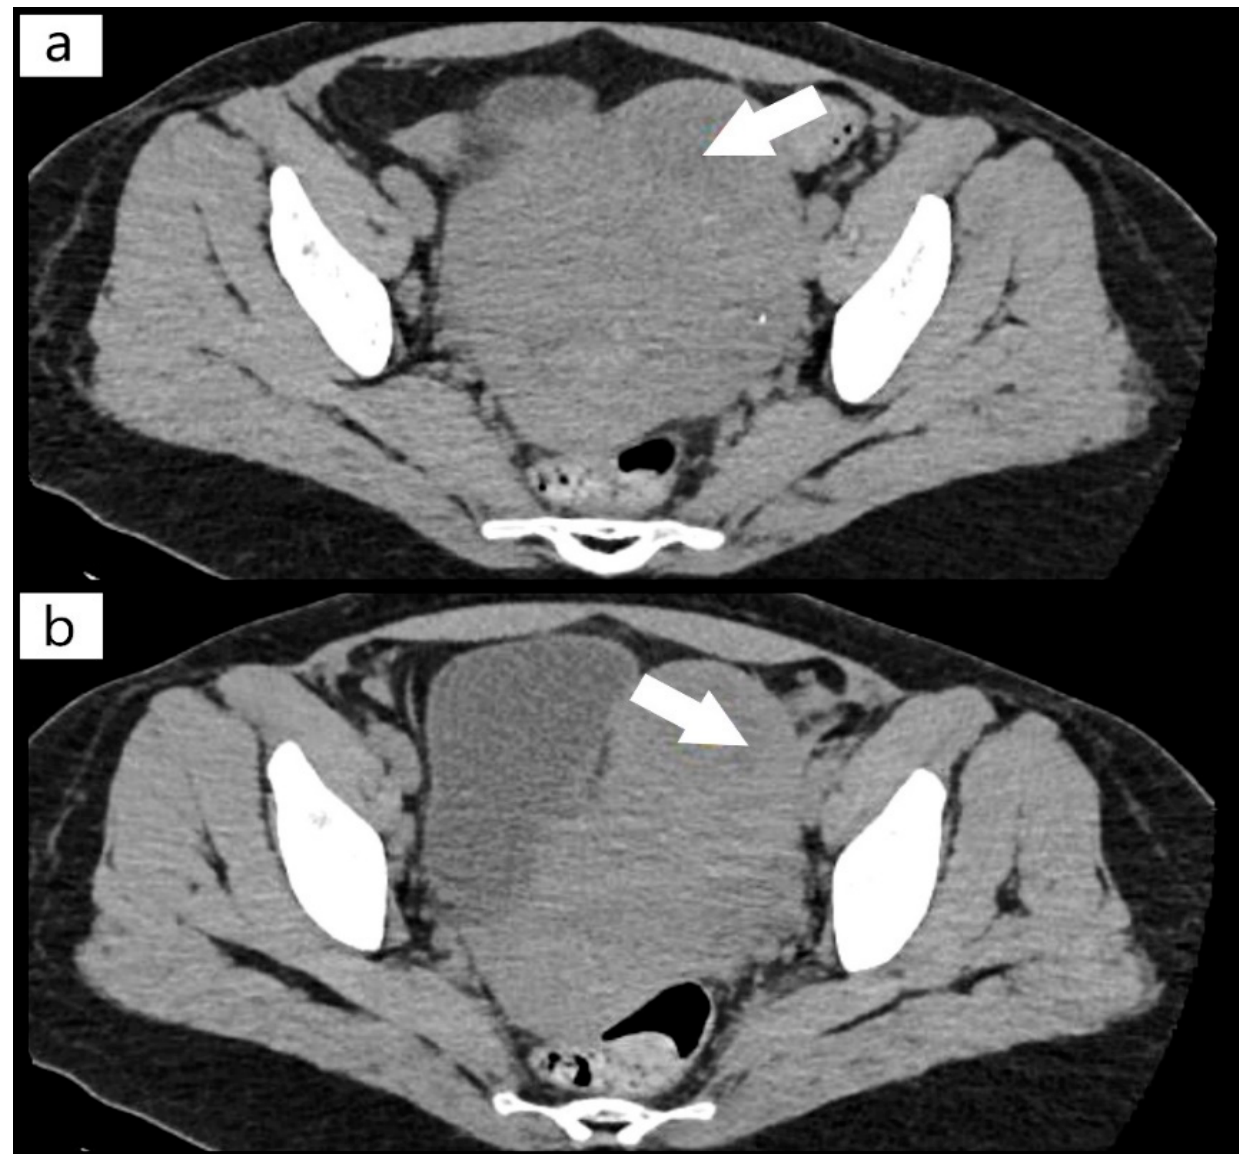
Figure 1. ( a , b ) Computer tomography (CT) scan with fibroid mass of the uterus (arrows).